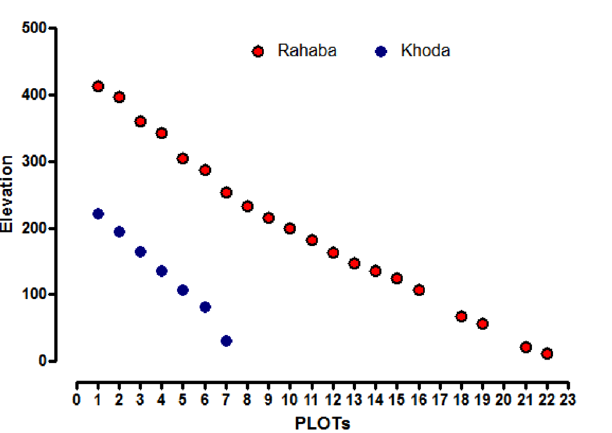
Figure 3. Photos showing two of the Vachellia tree taxa analyzed at the two wadis in Gebel Elba National Park, south-eastern Egypt. The two photos on the left side of the figure were taken at wadi Khoda and the two photos on the right side were taken at wadi Rahaba. Vachellia tortilis subsp. tortilis and V . tortilis subsp. raddiana are shown in these photos, but V . ehrenbergiana does not appear. The Gebel Elba mountain range is in the background of the bottom-right photo.